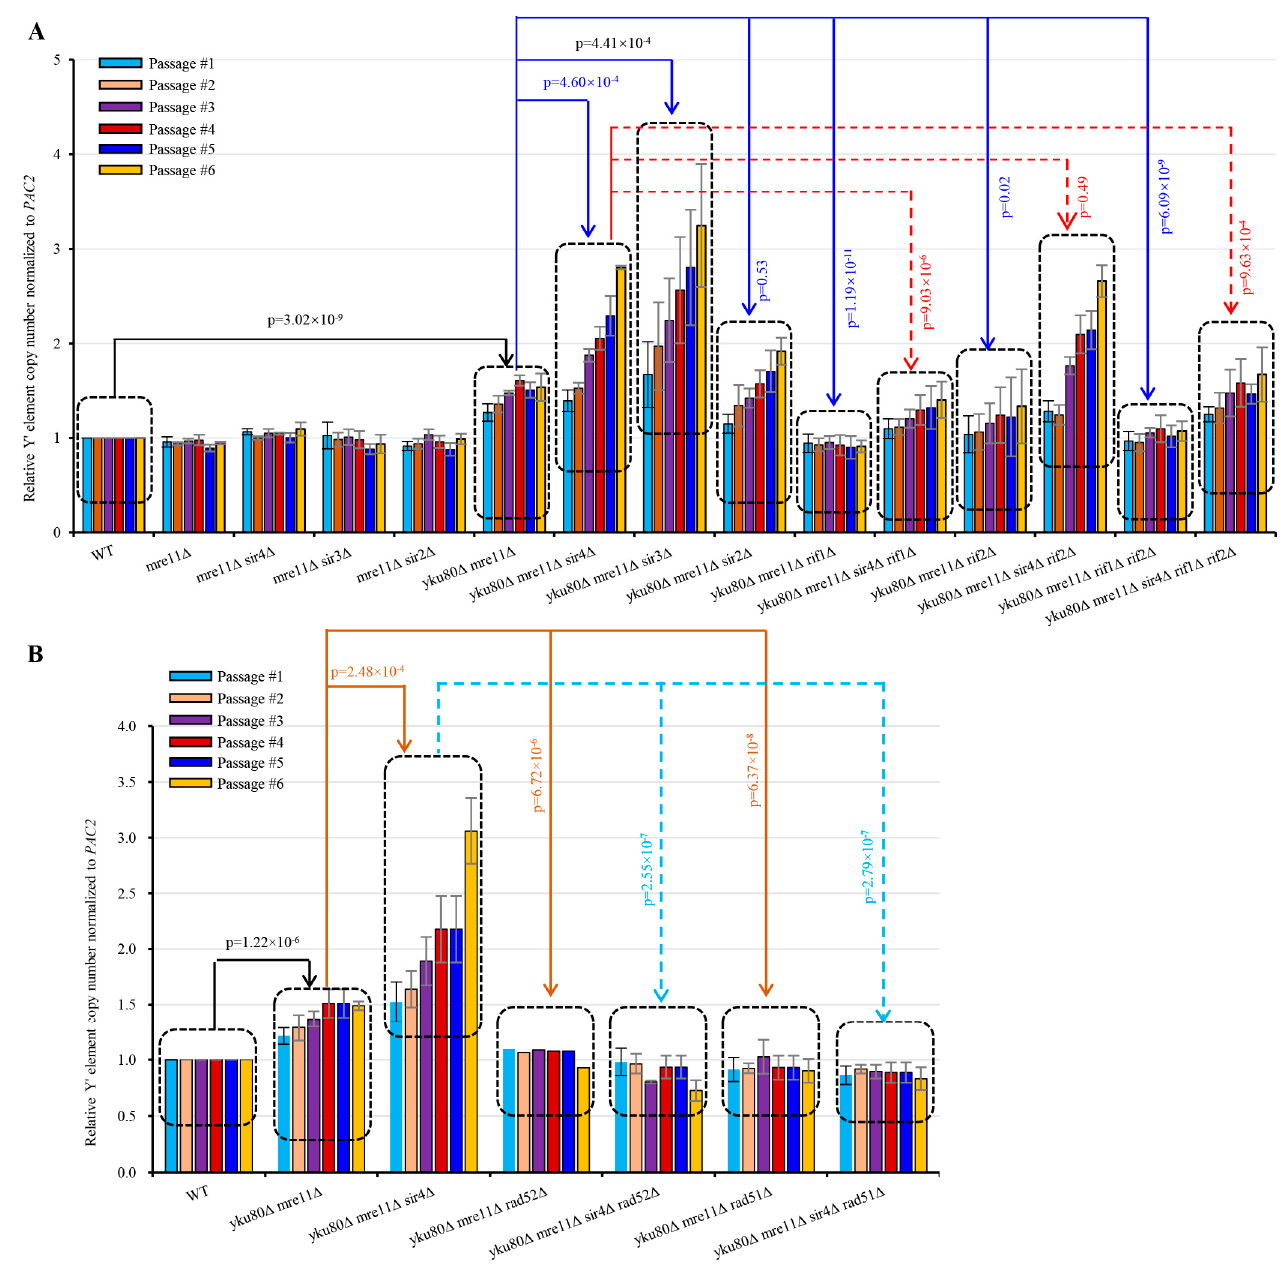
Figure 4. Effects of SIR2 , SIR3 , SIR4 , RIF1 , RIF2 , RIF1/2 , RAD52 , RAD51 , and RAD59 deletions on the Y (cid:48) element amplification of yku80 ∆ mre11 ∆ and of yku80 ∆ mre11 ∆ sir4 ∆ cells. ( A ) Spore cells yku80 ∆ mre11 ∆ and yku80 ∆ mre11 ∆ sir4 ∆ with or without RIF1 , RIF2 , or RIF1/2 deletions. ( B ) Spore cells yku80 ∆ mre11 ∆ and yku80 ∆ mre11 ∆ sir4 ∆ with or without RAD51 , RAD52 , or RAD59 deletion were passaged successively in liquid medium every 20 h. Genomic DNAs were isolated which was followed by qSACH analyses of Y’ element copy number. Data are ± SEM ( n = 5).